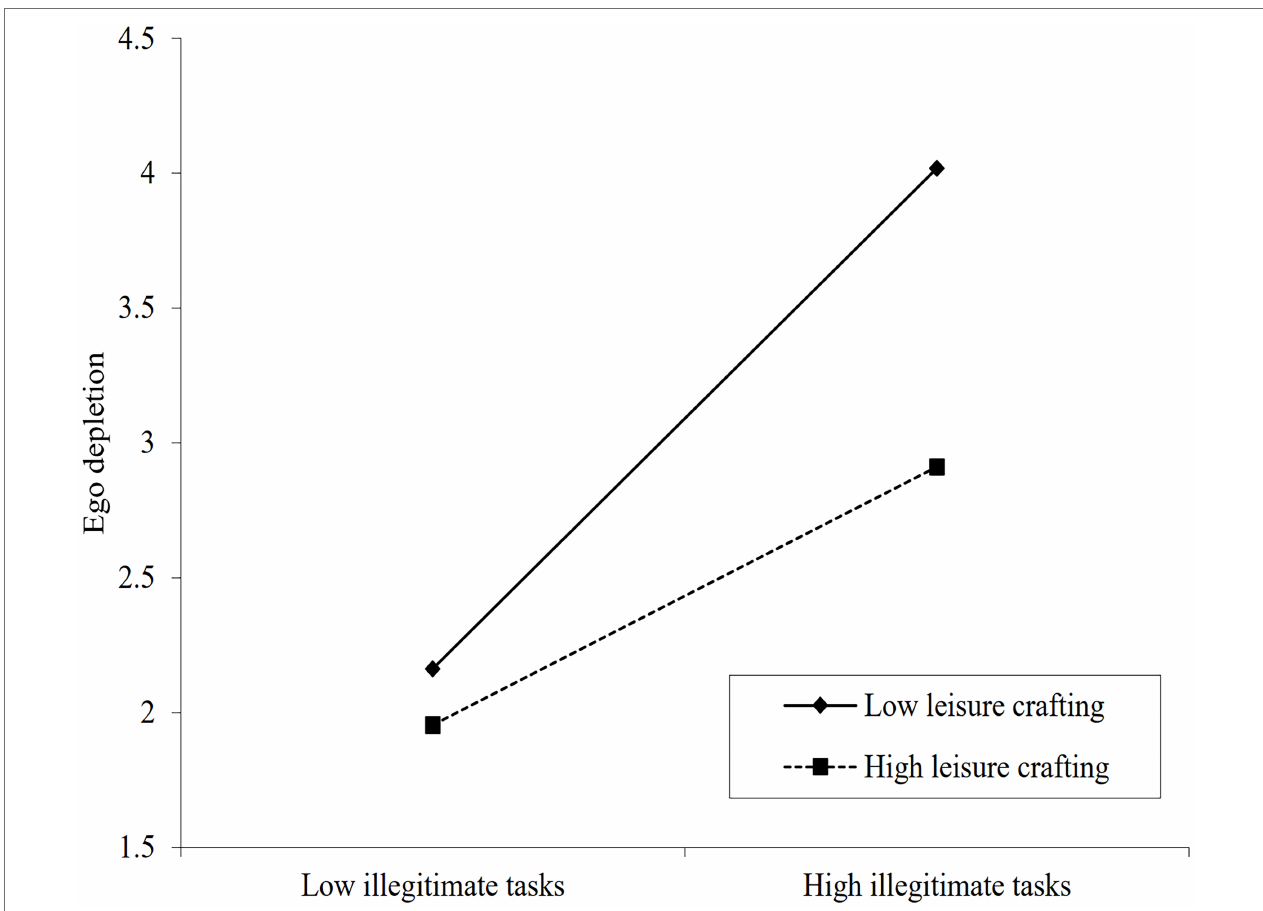
FIGURE 3 | Moderating effect of leisure crafting on relationship between illegitimate tasks and ego depletion.